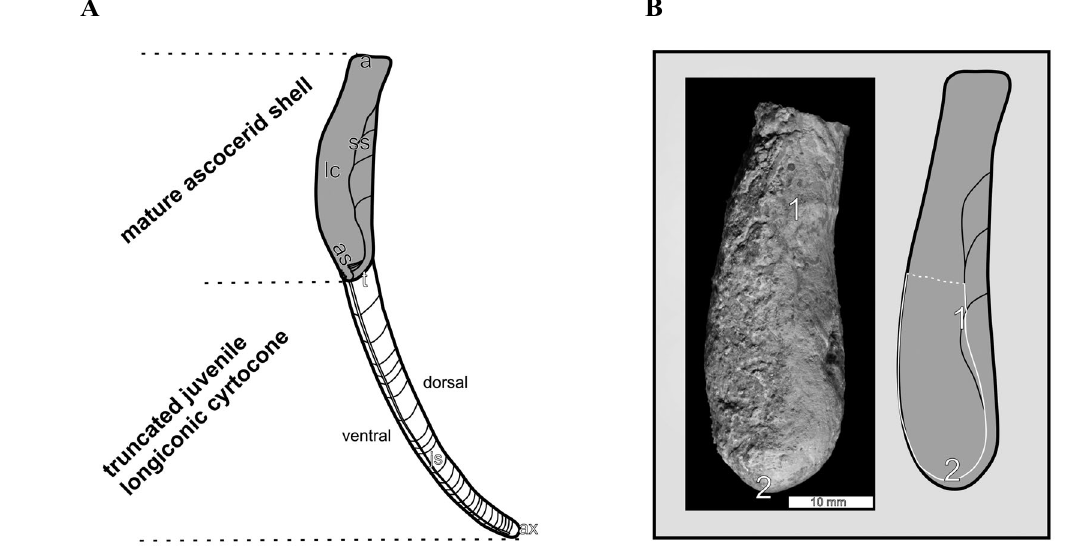
Fig. 2. General morphology of the ascocerids ( A ) and photograph and reconstruction of the studied specimen ( B ); a, aperture; as, ascocerid siphuncle; ax, apex; js, juvenile siphuncle; lc, living chamber; ss, sigmoidal septa. Adapted from Lindström (1890), terminology modified after Furnish & Glenister